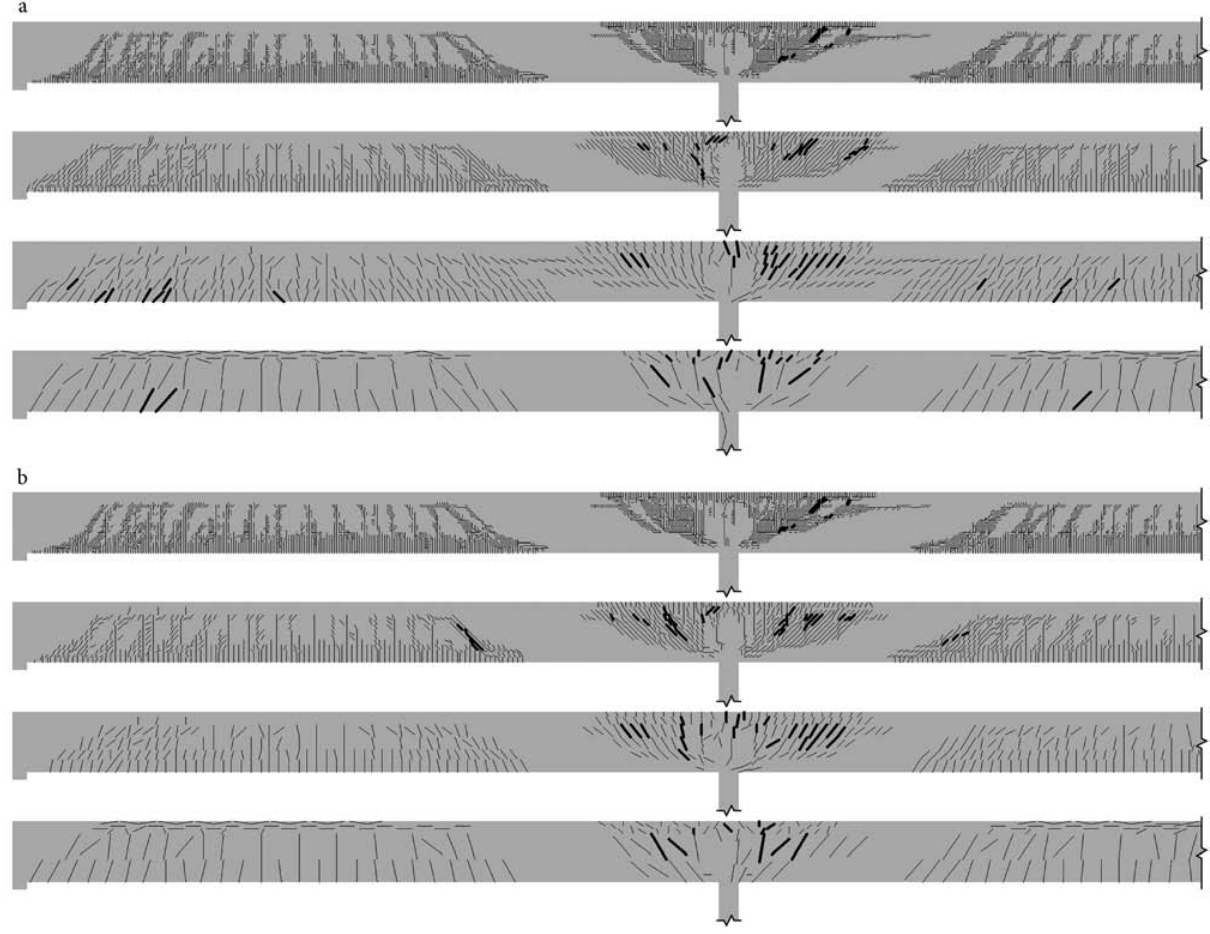
Fig. 8. Crack pattern of RC bridge girder simulated using fracture mechanics approach with different FE mesh